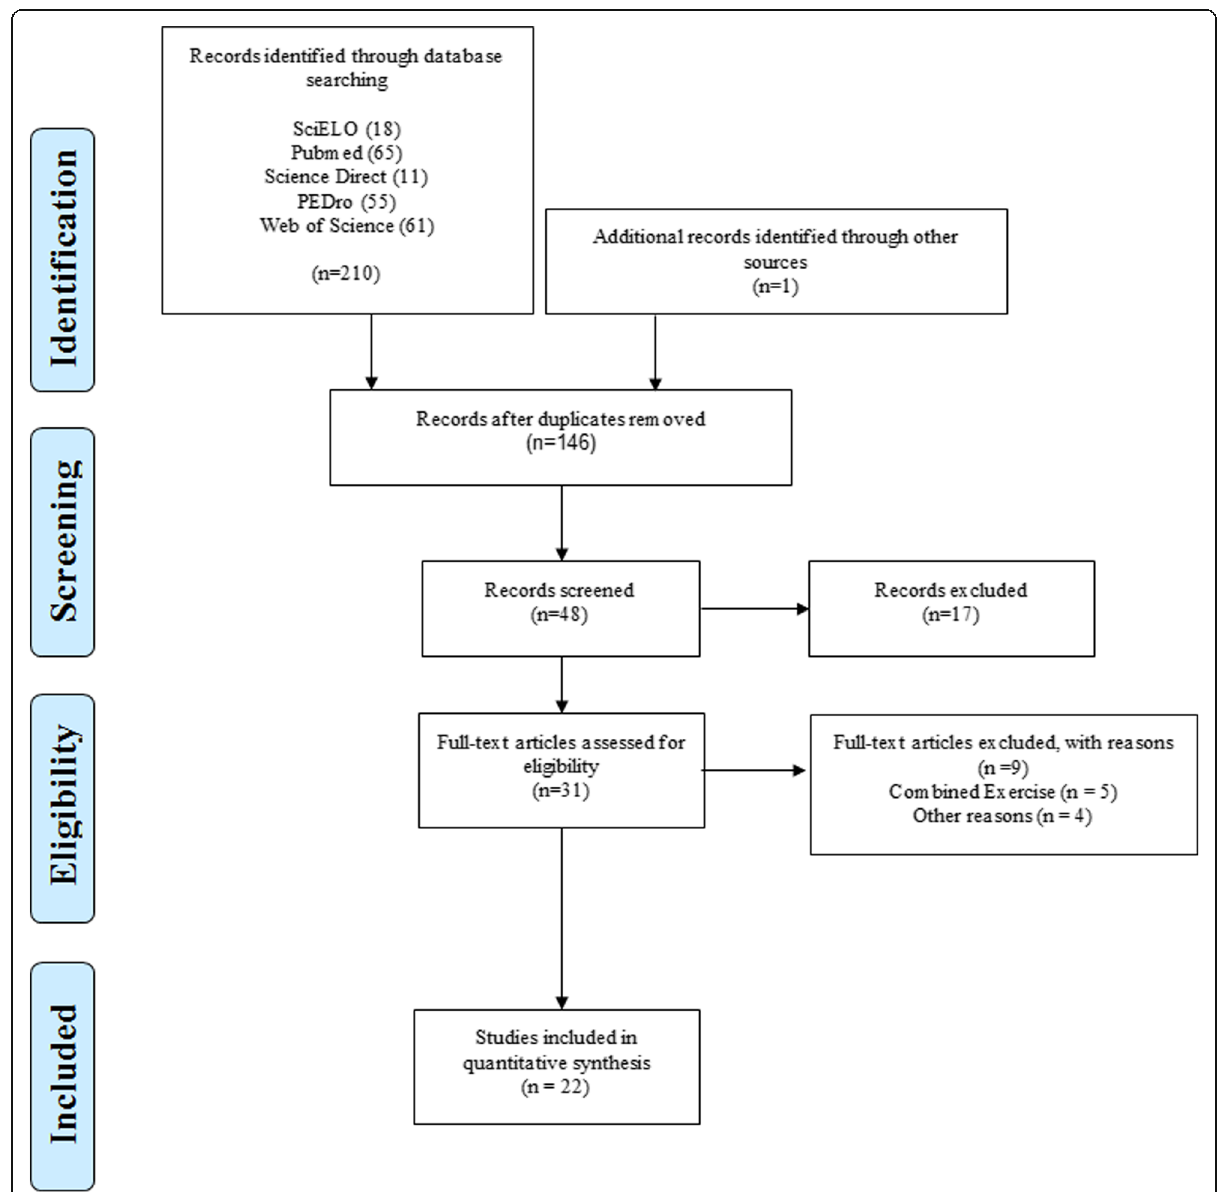
Fig. 1 Flowchart of the selection process of the reviewed articles for the